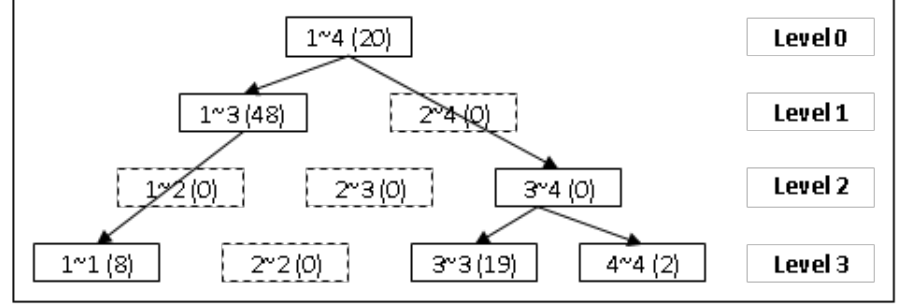
Fig. 6 An example of an